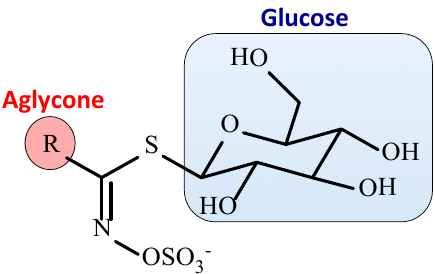
Figure 1. Generic structure of the Glucosinolates showing glucose, sulphation and the aglycone side chain (R) used to categorize the aliphatic, indolic or aromatic glucosinolates.